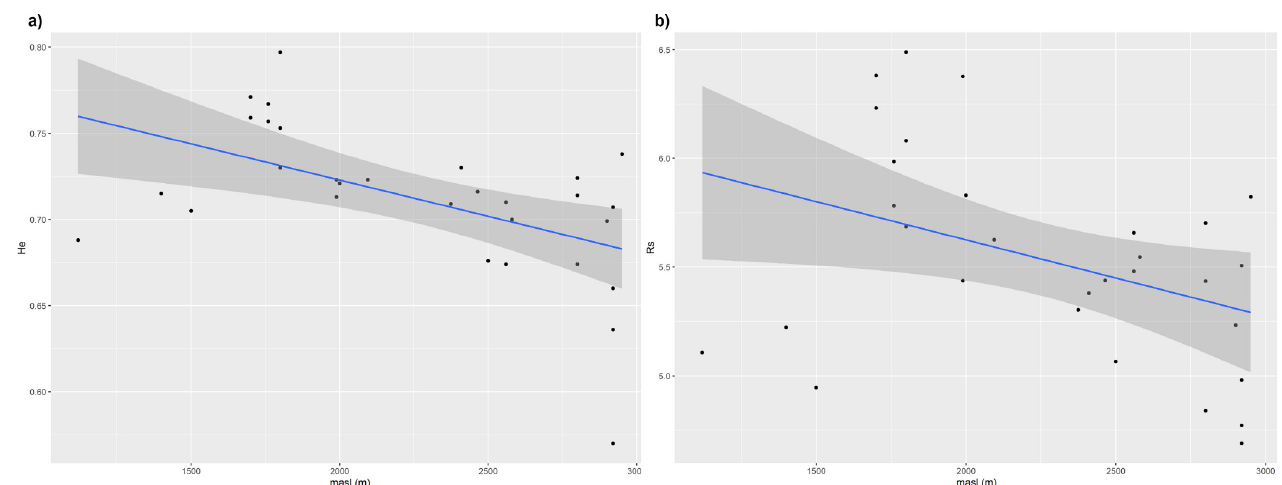
Fig 6. Correlation analysis between diversity estimates and altitude of the collection site. (a) Scatterplot of the correlation between altitude and expected Heterozygosity, He. (b) Scatterplot of the correlation between altitude and allelic richness, Rs.